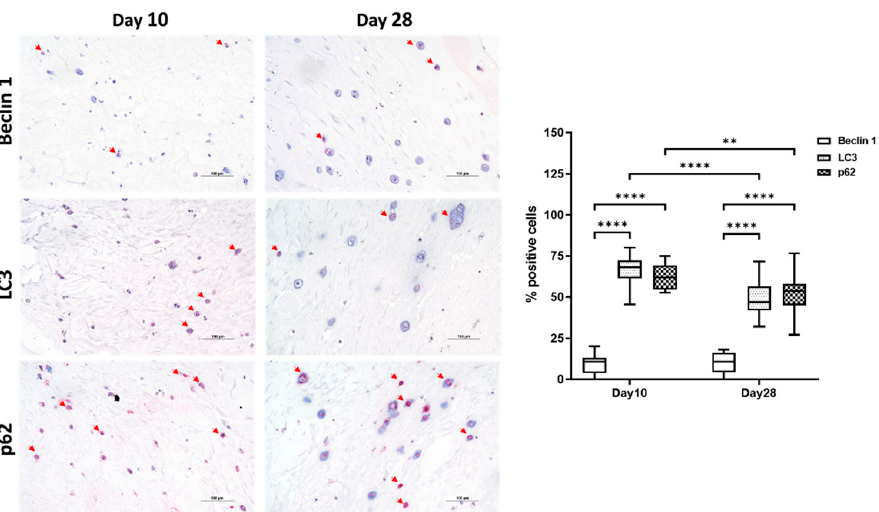
Figure 7. Immunohistochemical analysis of Beclin 1, LC3, and p62 proteins on chondrogenic differentiated hASCs embedded in VG-RGD at days 10 and 28. Bar = 100µm. Arrows indicate positive stained cells. Quantification of the percentage of positive cells was performed at days 10 and 28. Data were expressed as percentage of positive cells and represented as a boxplot with median, minimum, and maximum. Kruskal–Wallis with Dunn’s multiple comparisons test was used for statistical analysis: * indicates differences along time points (day 10 to day 28); ** p < 0.005, **** p < 0.0001.